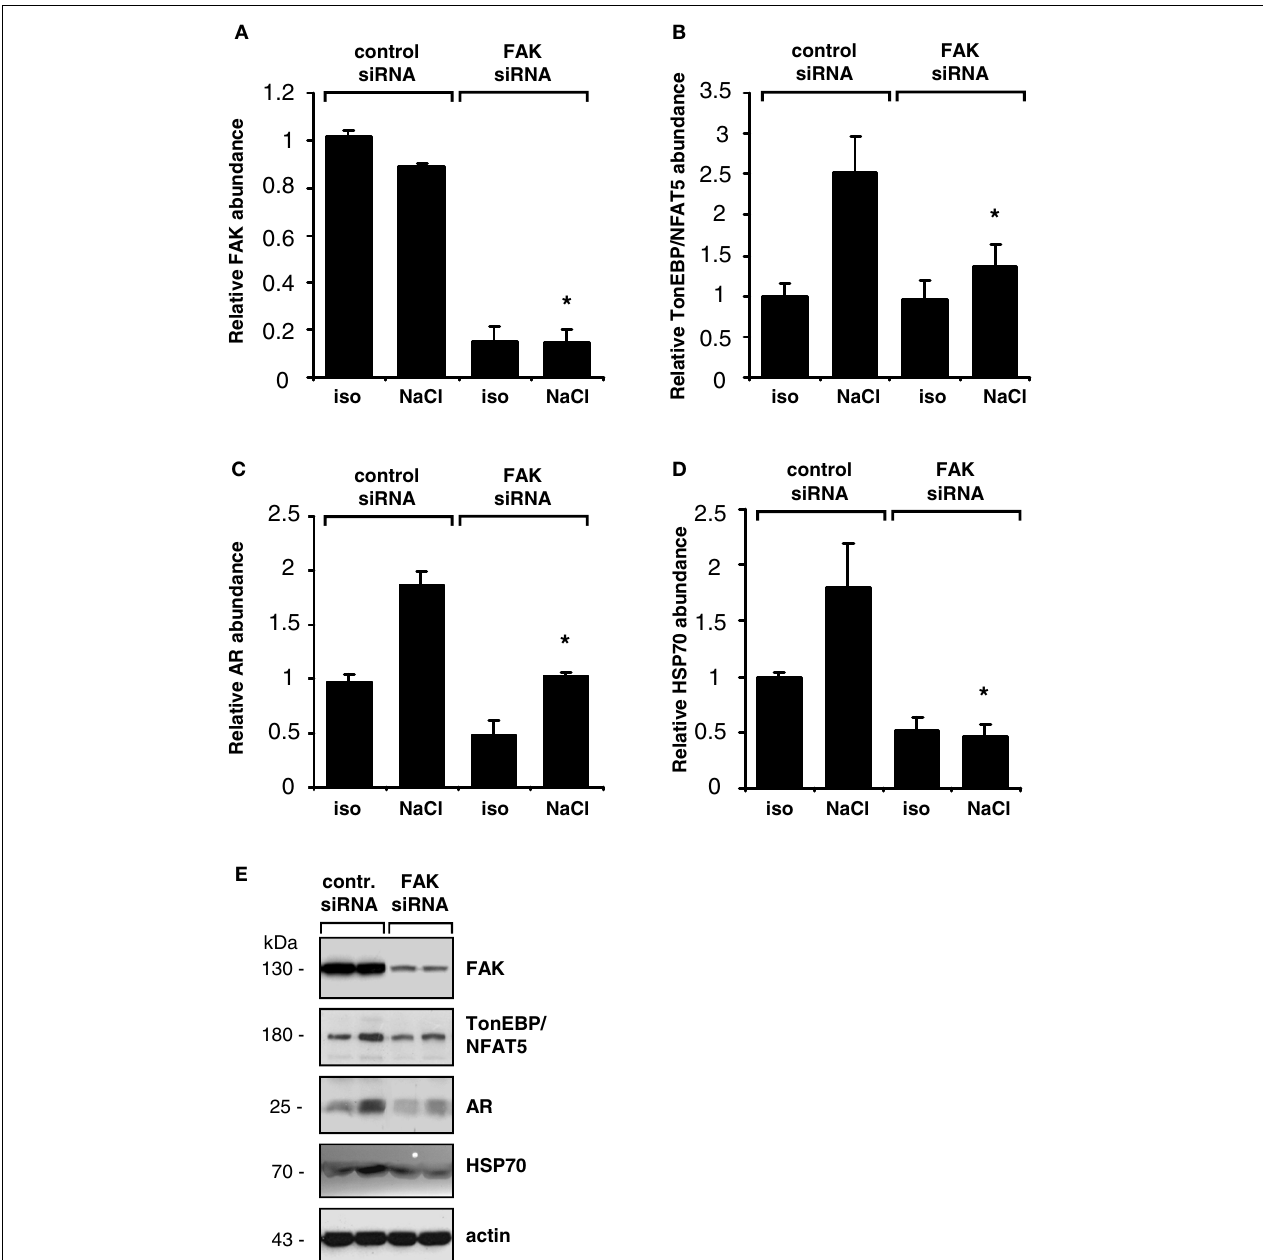
FIGURE 5 | Effect of FAK knockdown on TonEBP/NFAT5 and target gene expression. HEK293 cells transfected with siRNA specific for FAK or non-targeting control siRNA were incubated for 24h in isotonic (300mosm/kg H 2 O) or hypertonic medium (500mosm/kg H 2 O by NaCl